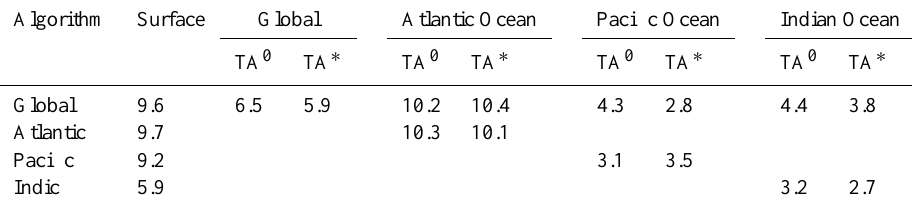
Table 2. Volume-weighted RMSEs of global and regional TA 0 and TA ∗ estimates. Errors given in column “Surface” refer to the ability of the respective algorithm to reproduce the surface (upper 100m) alkalinity of the model. Under TA 0 RMSEs of subsurface preformed TA as compared with TA 0 from the explicit tracer are given. Under TA ∗ RMSEs of computed TA ∗ compared with TA ∗ from the explicit tracer are given. Global algorithms are also evaluated concerning their skill on regional